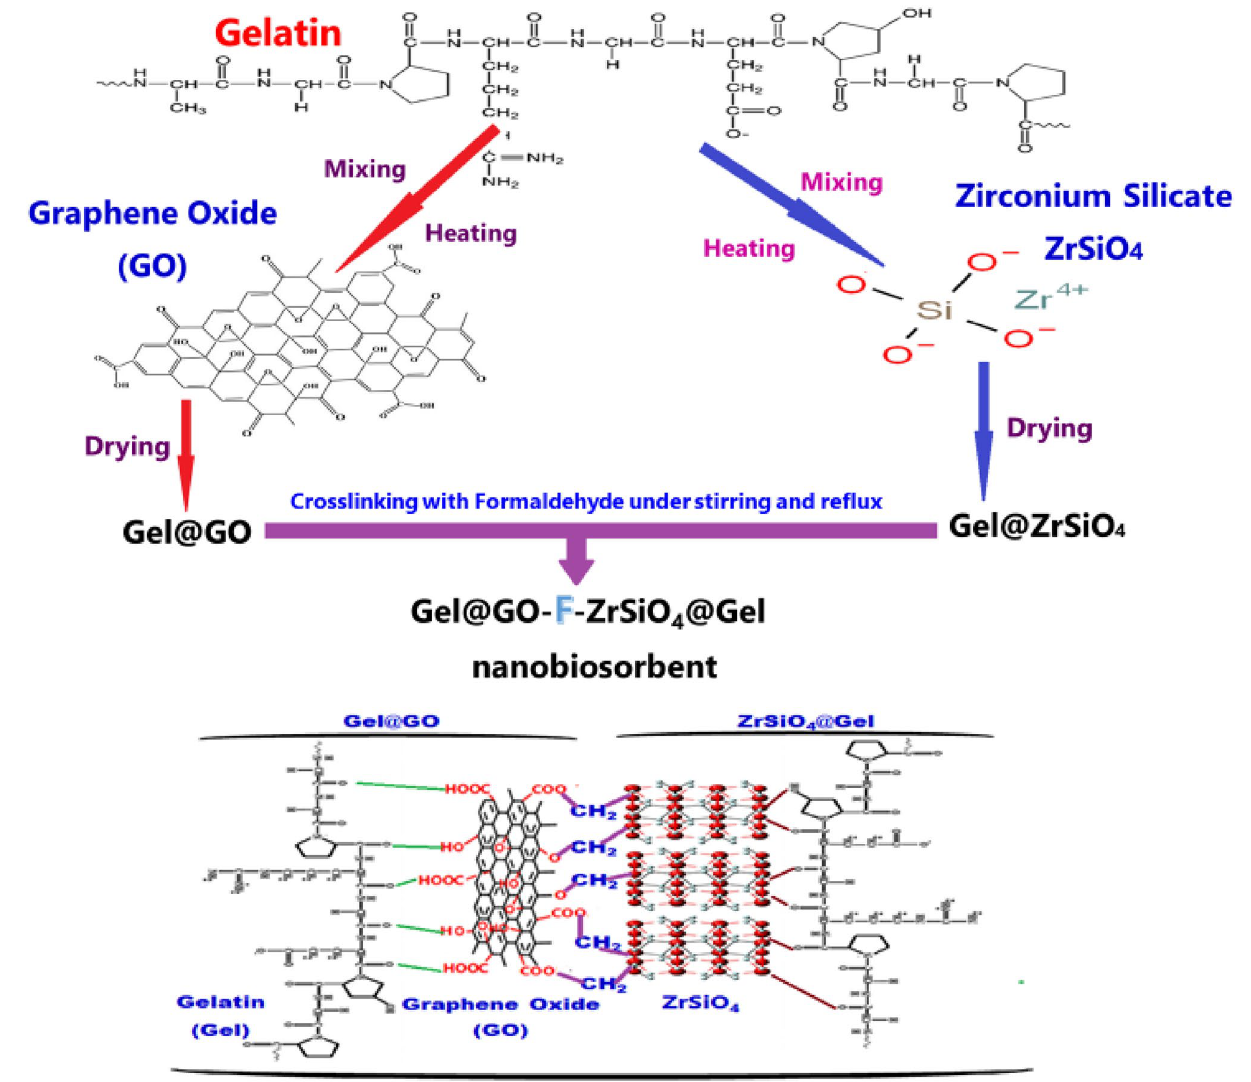
Figure 1. Synthesis of Gel@GO-F-ZrSiO 4